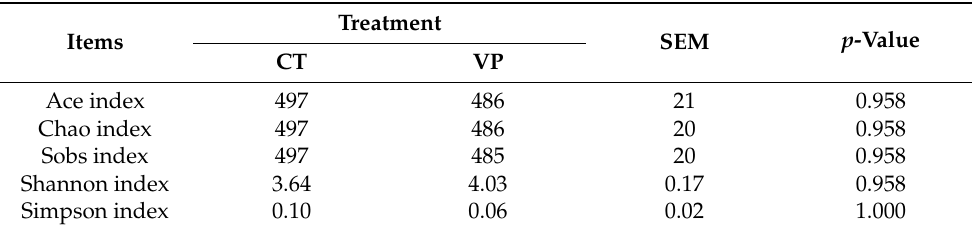
Figure 2. Effects of dietary supplementation with stimbiotics on faecal microbial communities. ( A ) ASVs Venn diagram. ( B ) Faecal microbial β− diversity based on the ASVs level. Table 5. Effect of dietary supplementation with stimbiotics on fecal microbiota α diversity of weaned